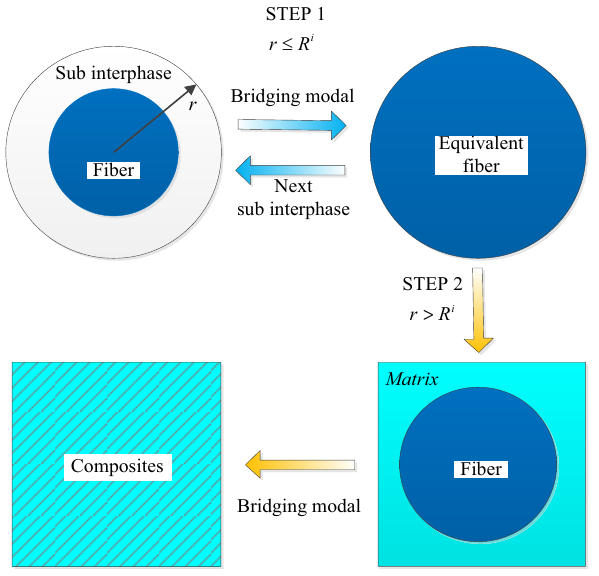
Figure 4: The modal of equivalent fi ber.